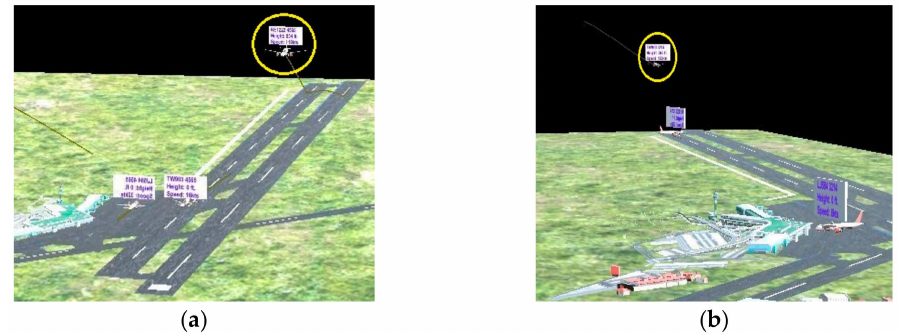
Figure 3. A detailed view of the airfield from di ff erent angles in a holographic mixed reality. The detail view: ( a ) Shows an airplane’s takeo ff ( b ) Shows landing of an